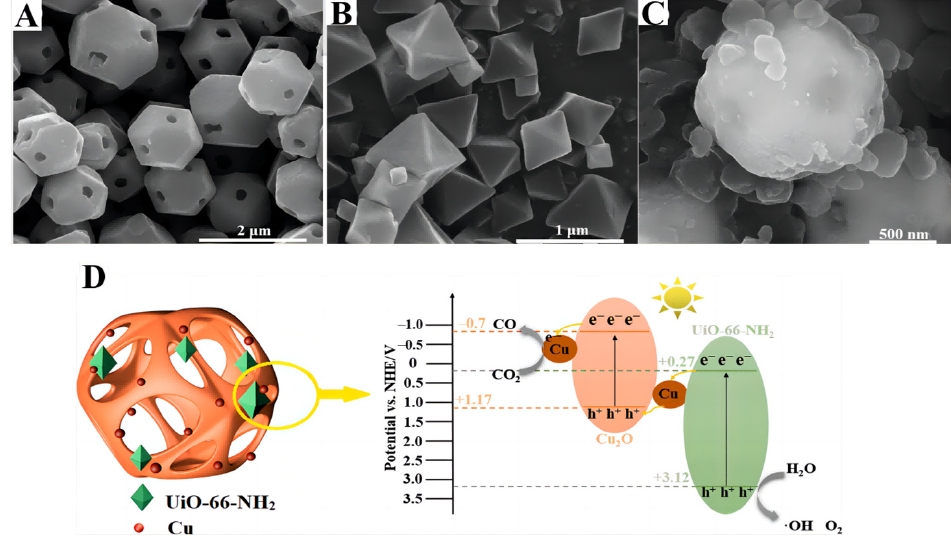
Figure 18. ( A – C ) SEM results of Cu 2 O, UiO-66-NH 2 and U/C/Cu-0.39. ( D ) Illustration of the photocatalytic CO 2 reduction in U/C/Cu-0.39 [122].